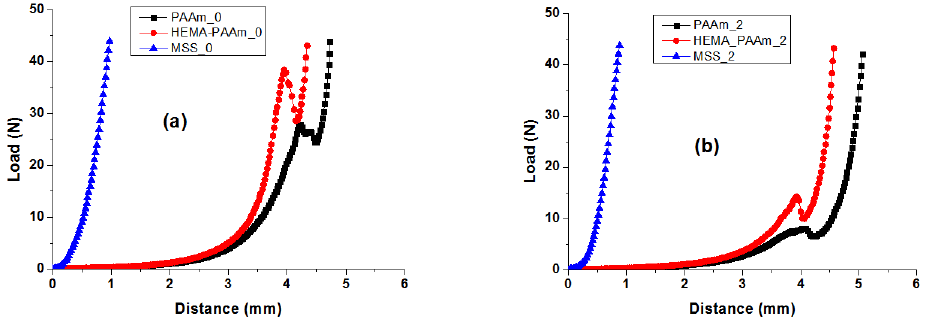
Figure 7. Compression tests for: a) fresh supports; b) structures used in 2 consecutive days of